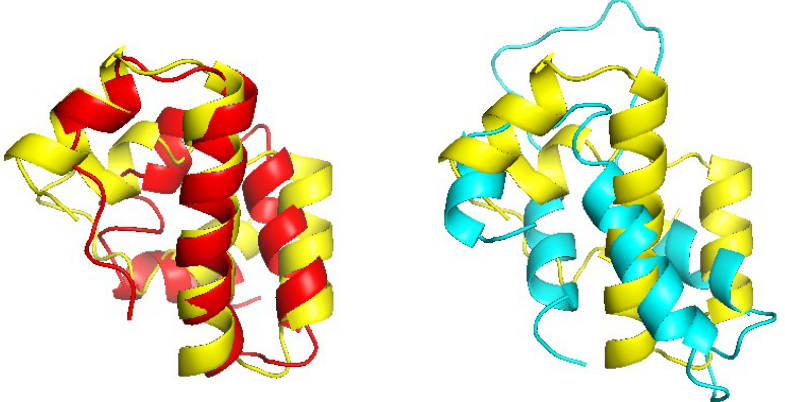
Figure 16. ( Left ) Structure model of the target T1082-D1 based on CRFalign alignment of T1082-D1- 6h7bC (red) overlapped with the experimental structure of T1082-D1 (yellow) (with TM score = 0.5656, rmsd = 3.01) and ( right ) that based on HHalign alignment (cyan) overlapped with the experimental structure (yellow) (with TM score = 0.2499, rmsd = 8.83